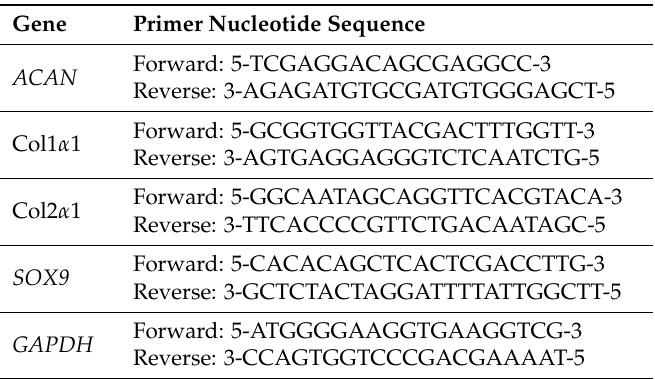
Table 1. Primer sequences used in